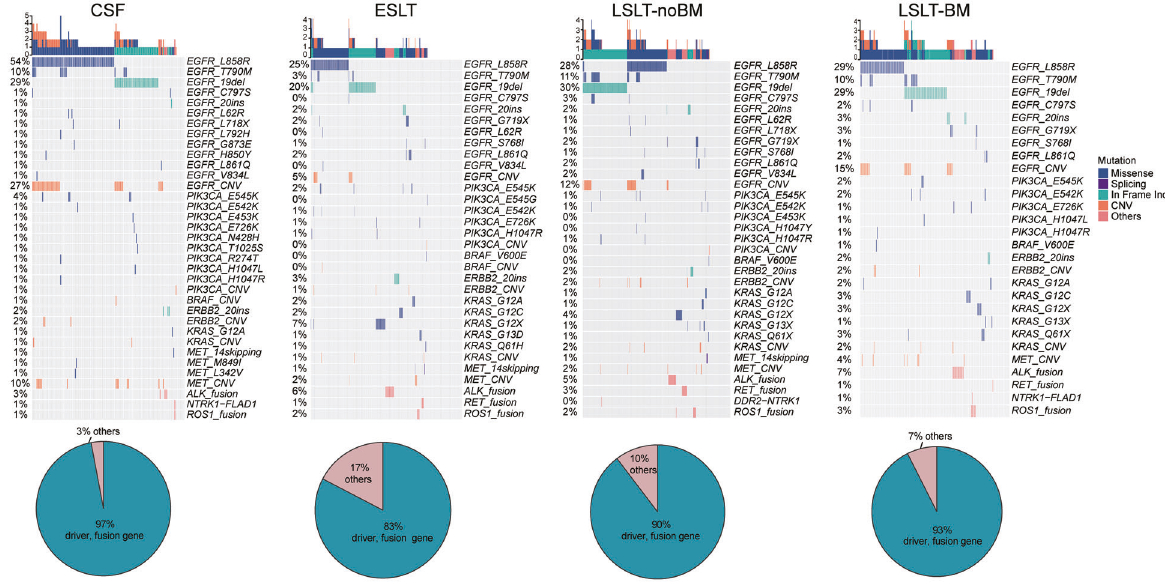
Fig. 6 Genotyping pro fi les of the targeted drugs related diver genes. The mutation landscape of several actionable driver alterations and gene rearrangements in lung cancer is shown at the top. Pie charts at the bottom indicate the proportion of these druggable